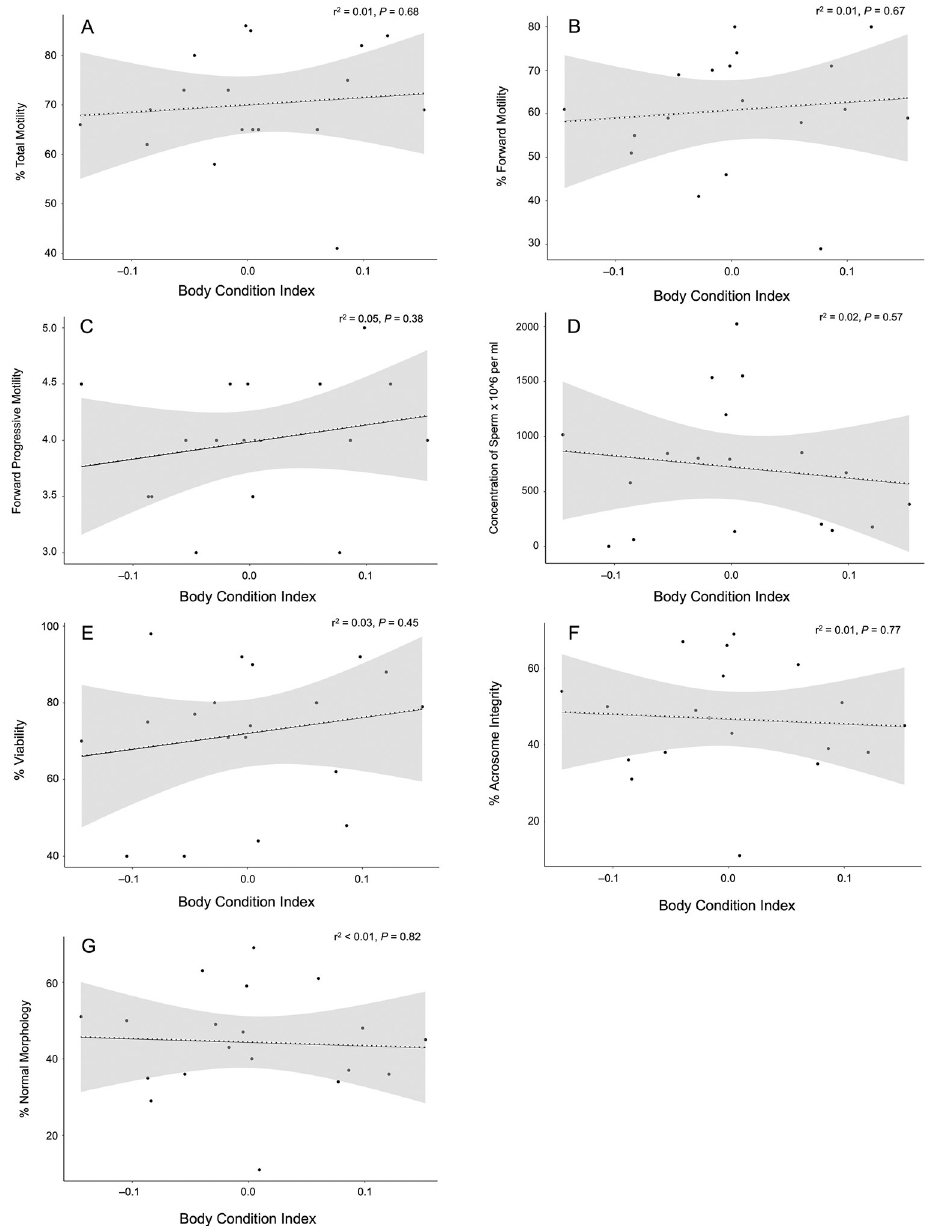
and percent viability of sperm, F) BCI and percent acrosome integrity, and G) BCI and percent normal morphology of semen from 20 adult male Louisiana pinesnakes. Dashed lines represent a non-significant regression line at the 0.05 level and shading shows the 95%